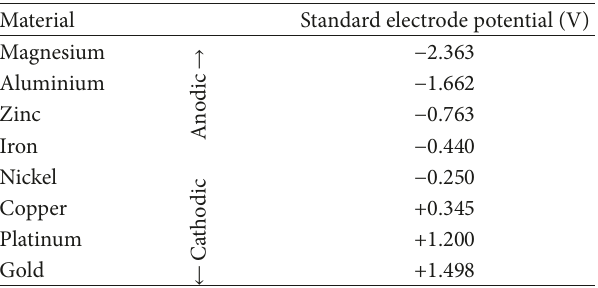
Table 1: Partial standard electromotive force series as measured against a hydrogen reference electrode